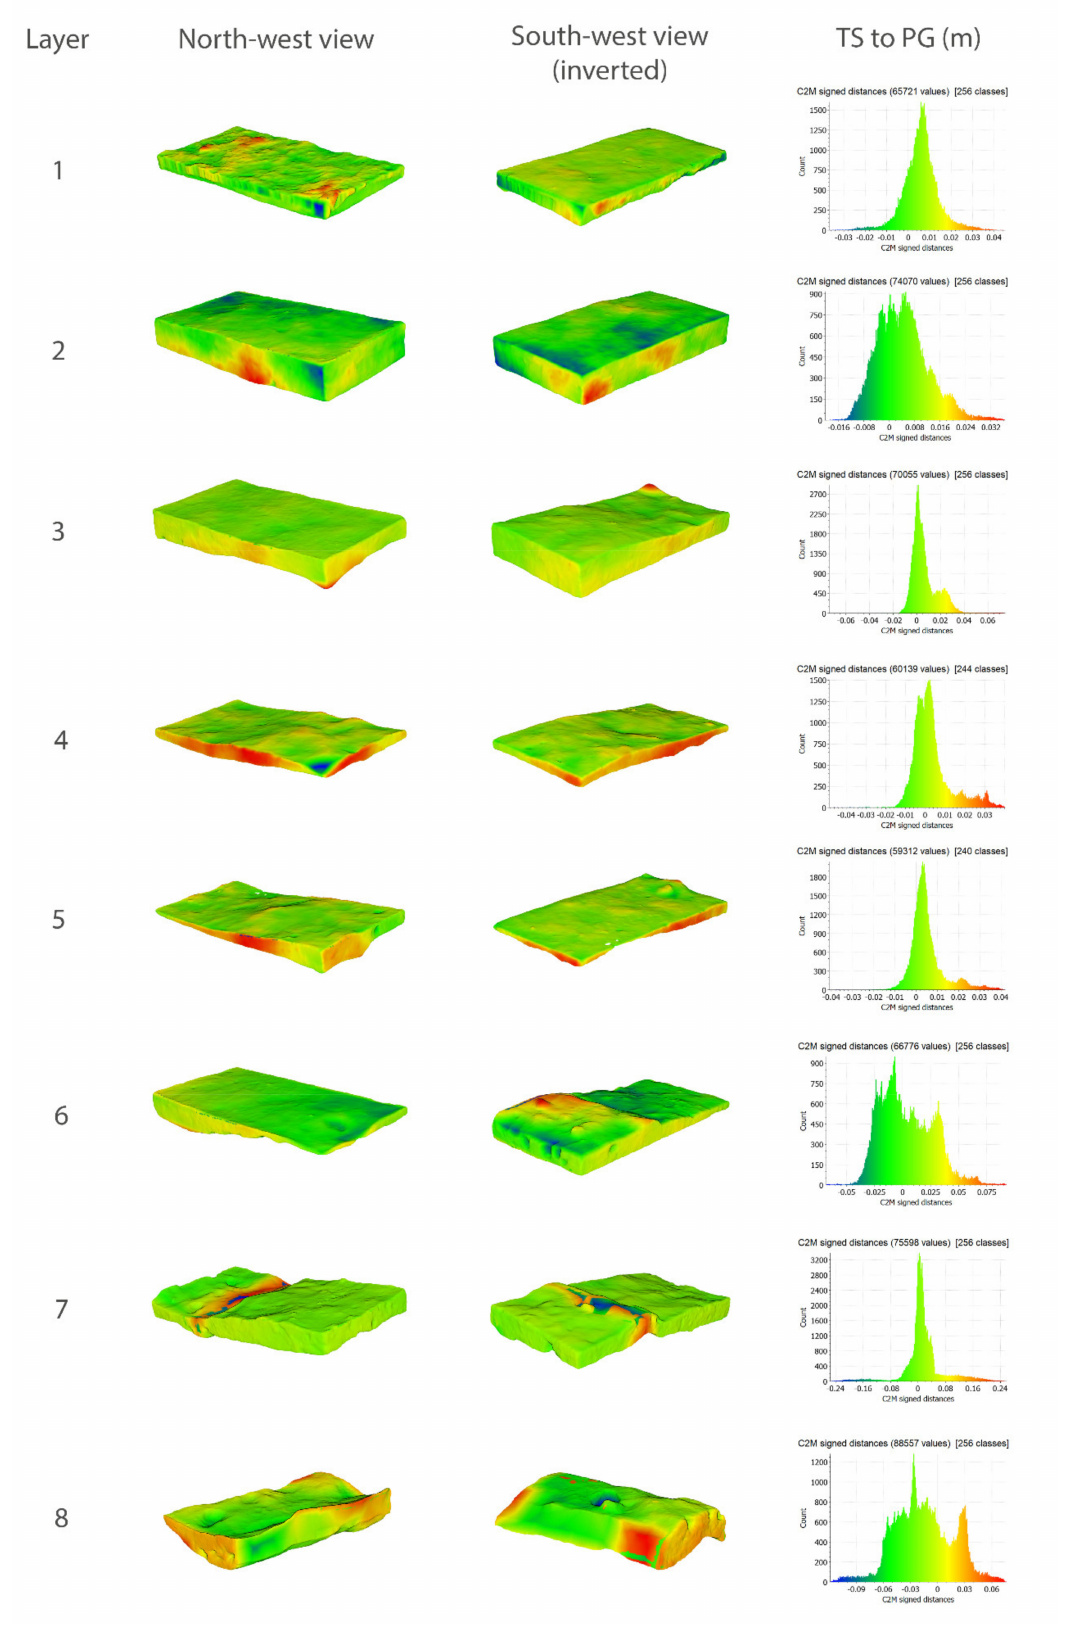
Figure 7. Comparison of the TS mesh onto the PG mesh by